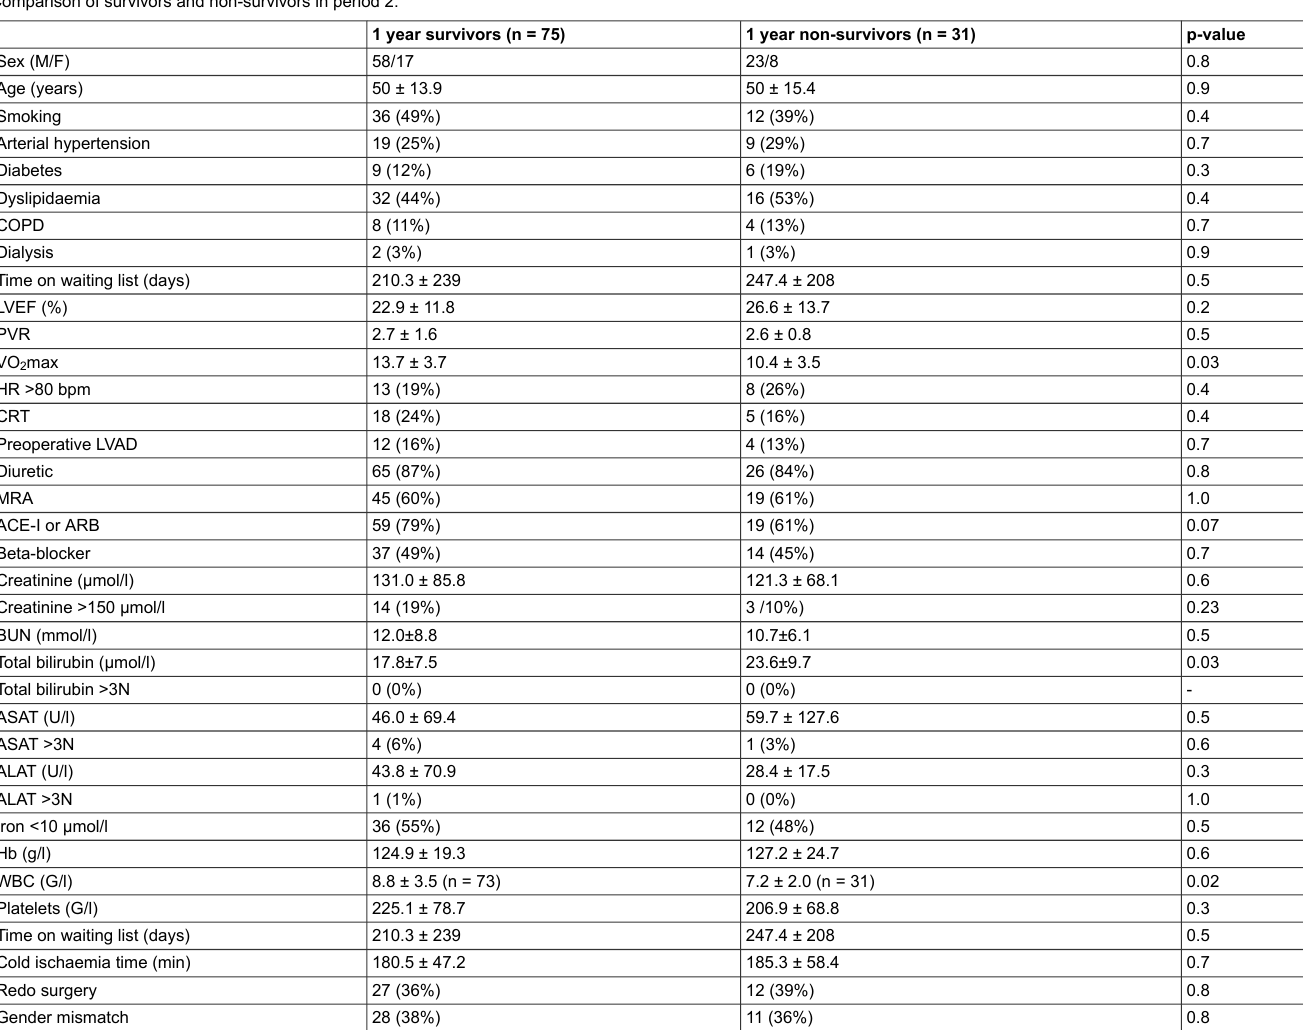
Table S4: Comparison of survivors and non-survivors in period